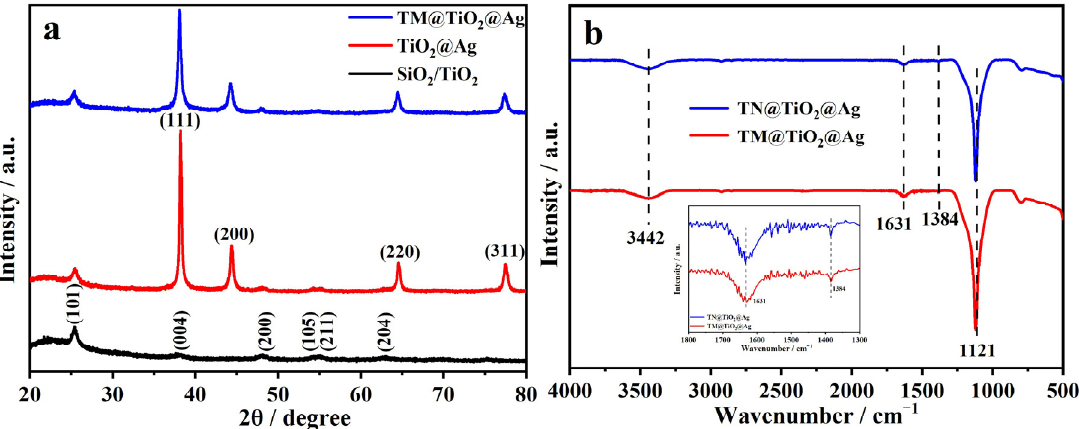
Figure 2. XRD patterns of SiO 2 /TiO 2 , TiO 2 @Ag, and TM@TiO 2 @Ag ( a ); FT-IR spectra of Figure 2.